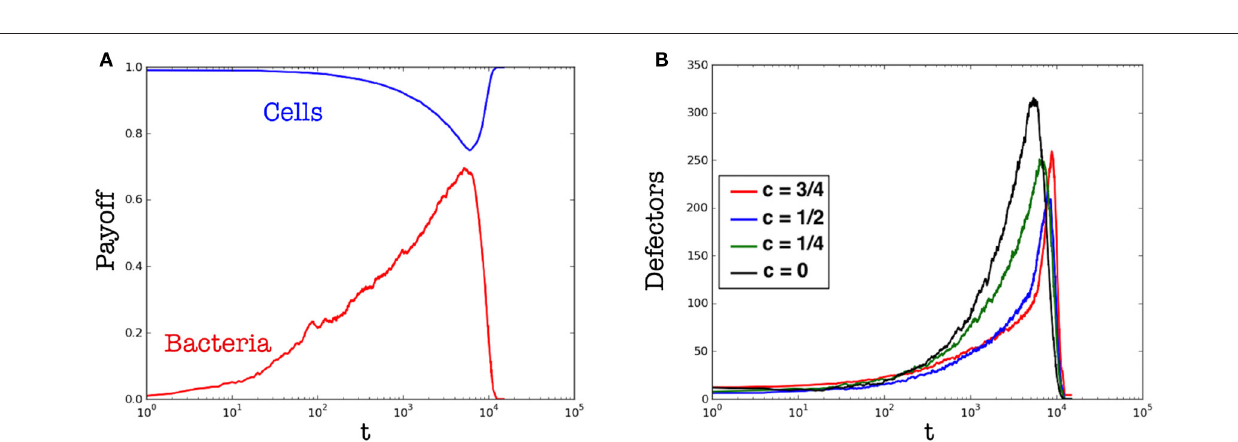
FIGURE 7 | Variation of the payoff over time. ( A ) Payoff of cells (blue line) vs. that of parasites (red line). ( B ) Fraction of defectors among cells. Cells are induced to defect by reducing their energy support to the organism in different fractions. Red, blue, and green lines indicates partial cooperators providing, respectively, a contribution to the organism equal to: 3 4 , 1 2 , 1 4 . Instead, black line indicates full defectors, i.e., cells that use the whole energy contribution to fight parasites. Results are averaged over different